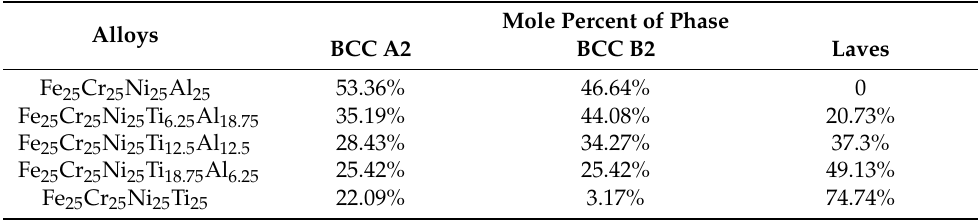
Table 1. The molar percentage of each phase of the Fe 25 Cr 25 Ni 25 Ti x Al (25-x) alloy at 800 ◦